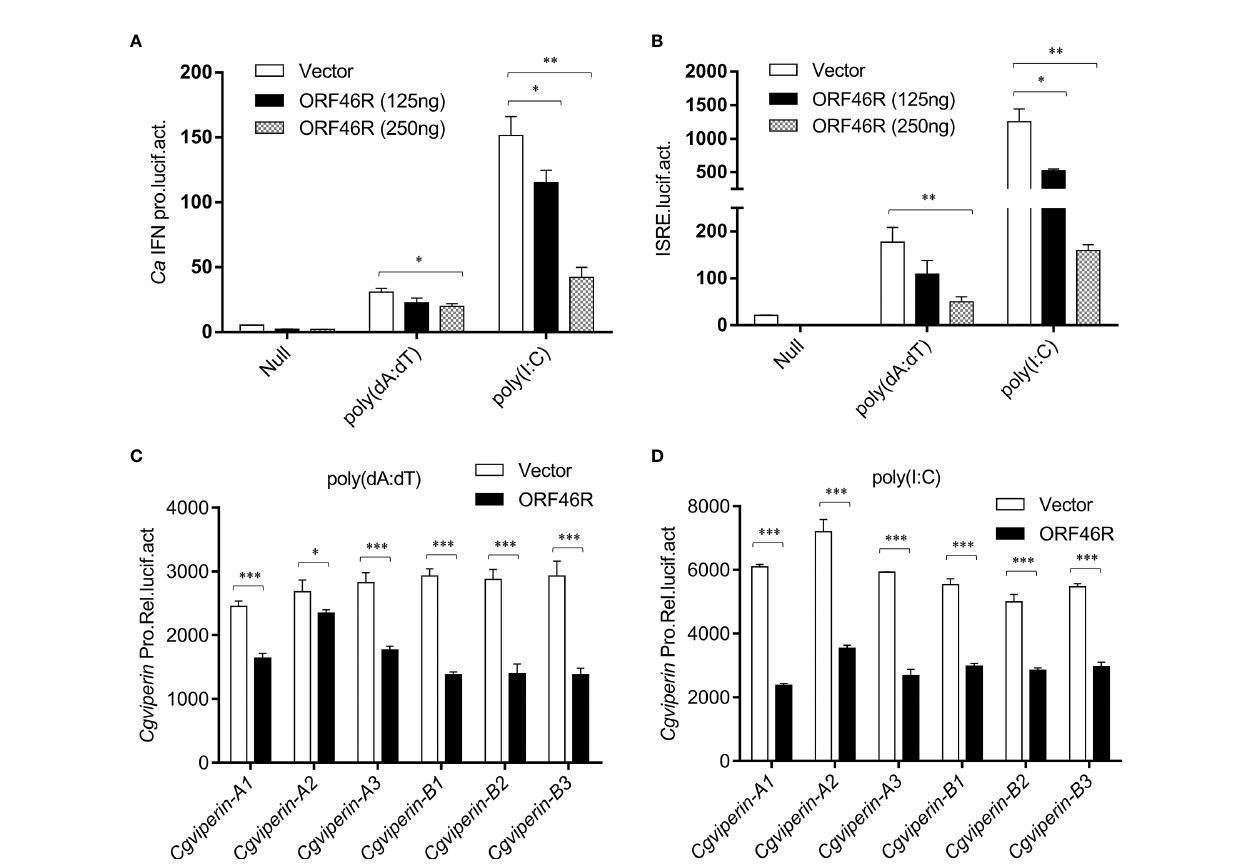
FIGURE 5 | Ca HV ORF46R blocks poly (dA:dT) or poly (I:C)-triggered activation of CaIFN promoter (A) , ISRE luciferase reporter (B), and six Cgviperin promoters (C, D) . CAB cells seeded overnight were co-transfected the empty vector or ORF46R (250 ng) and 25 ng pRL-TK plus 250 ng Ca IFNpro-luc or ISRE-luc. At 24 h post-transfection, cells were untreated (null) or transfected with 1 m g poly (dA:dT) or poly (I:C). The luciferase activities were monitored 24 h after stimulation. Each bar represents mean ± standard deviation (SD) (n = 3). * P < 0.05, ** P < 0.01, *** P <